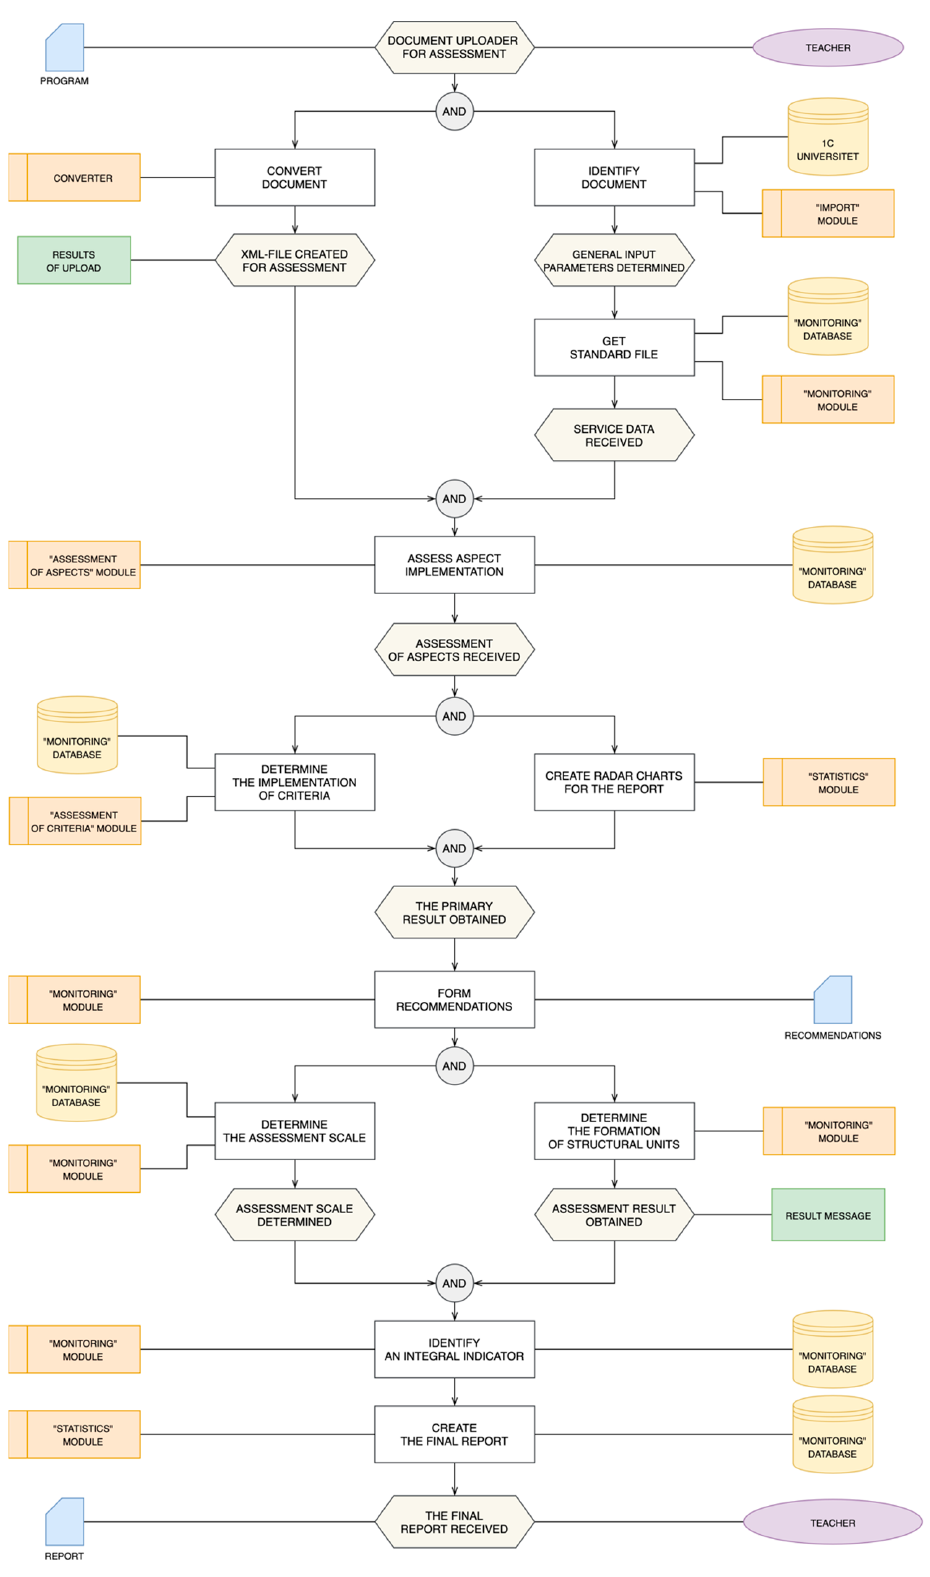
Figure 6. Event-driven process chain of the process of assessing the formal part of a fragment of an educational program.